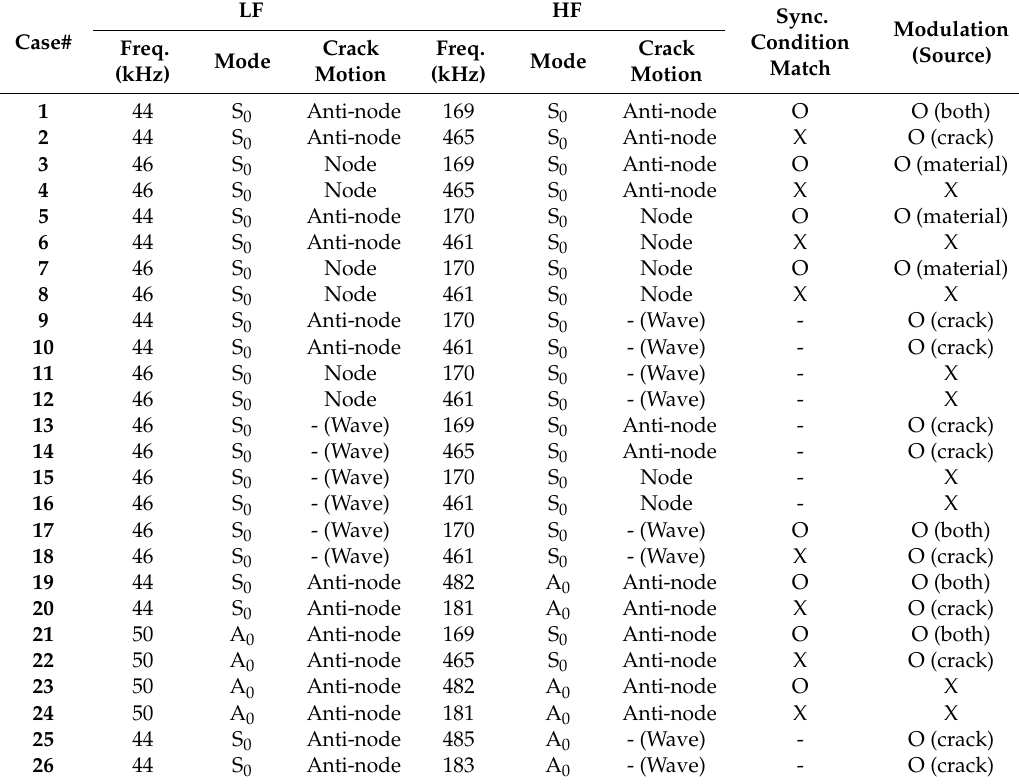
Table A1. Nonlinear ultrasonic modulation generation experimental